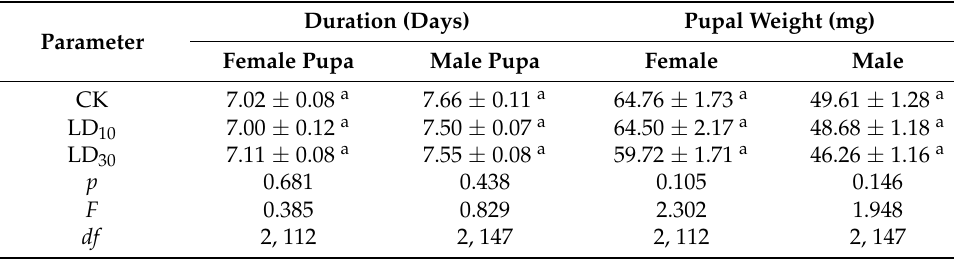
Table 7. Sublethal effect of fluxametamide on duration and weight of F 1 C. suppressalis pupa. Parameter